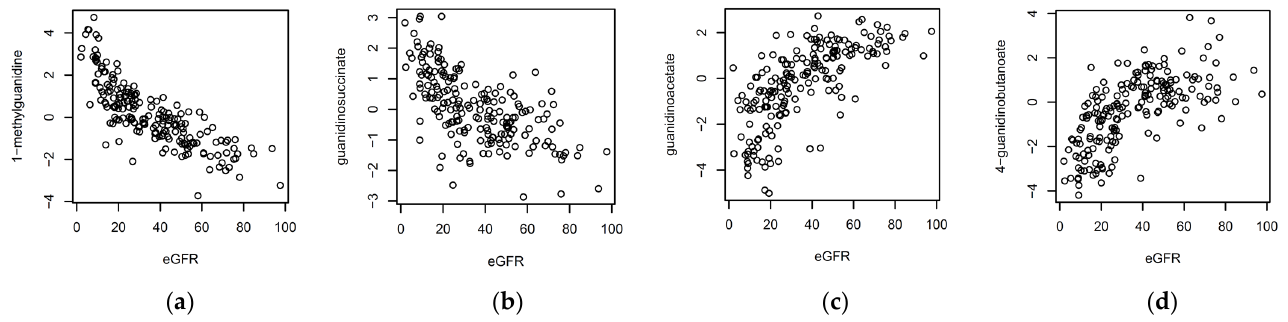
Figure 4. Scatterplots of ( a ) 1-methylguanidine, ( b ) guanidinosuccinate, ( c ) guanidinoacetate, and ( d ) 4-guanidinobutanoate versus eGFR, summary statistics (effect size, standard error, and p -value) for the metabolite associations with eGFR are in Table S6.